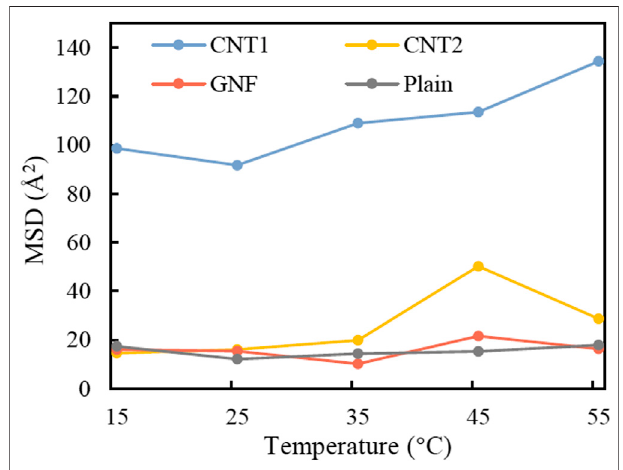
FIGURE 9 | Effect of carbon materials on mean square displacement at different